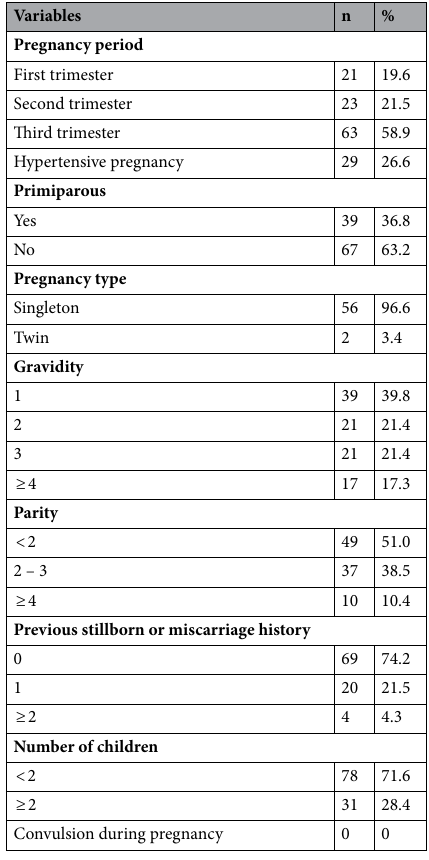
Table 2. Obstetrical characteristics of the respondents. Hypertensive pregnancy: SBP ≥ 140 mmHg and/or DBP ≥ 90 mmHg 25 . Primipara means first pregnancy.